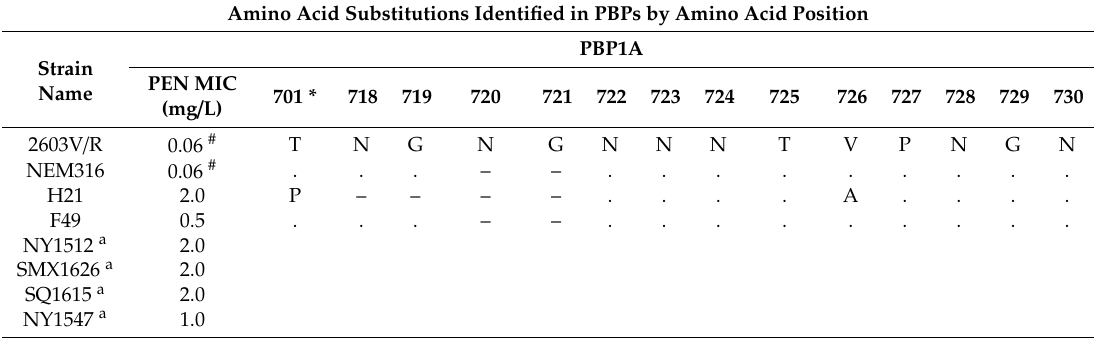
Table 3. Amino acid substitutions of penicillin-binding proteins PBP1A, 1B, 2A, 2B, and 2X. Amino Acid Substitutions Identified in PBPs by Amino Acid Position